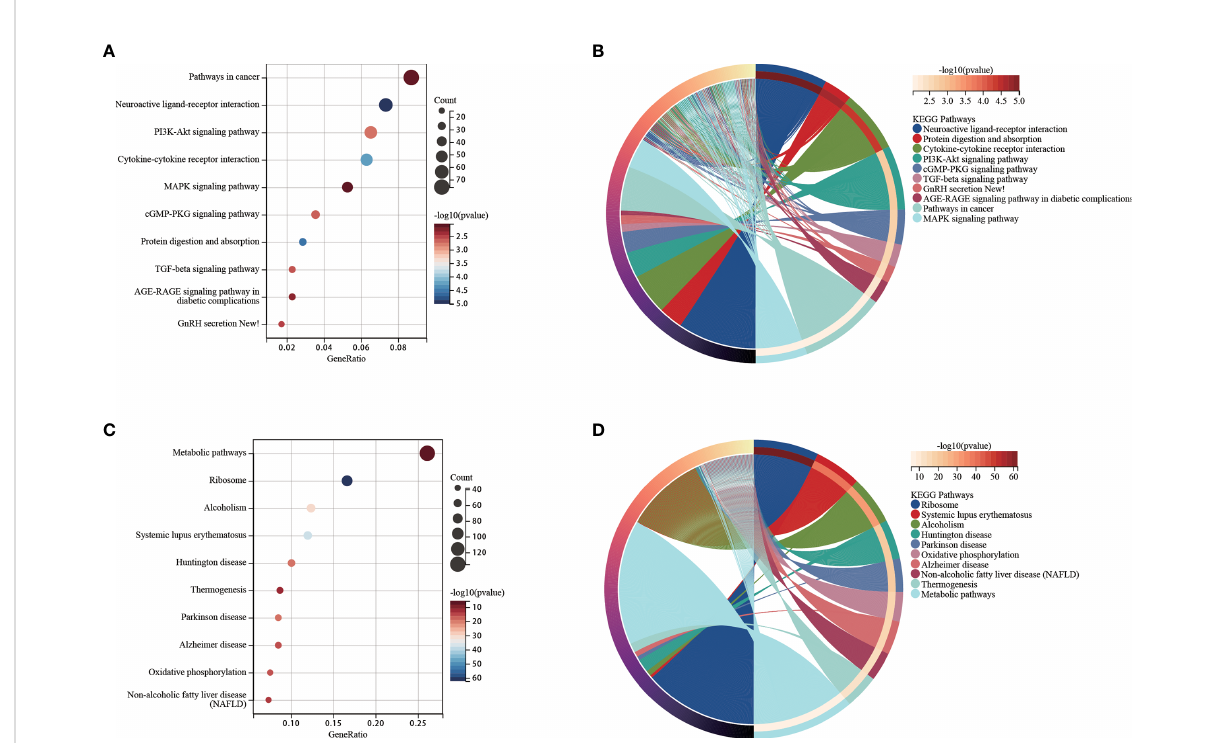
FIGURE 6 (A) Functional analysis for up-regulated genes in the K1 subgroup. (B) Chord diagram of enriched terms for up-regulated genes in the K1 subgroup. (C) Functional analysis for up-regulated genes in the K0 subgroup. (D) Chord diagram of enriched terms for up-regulated genes in the K0